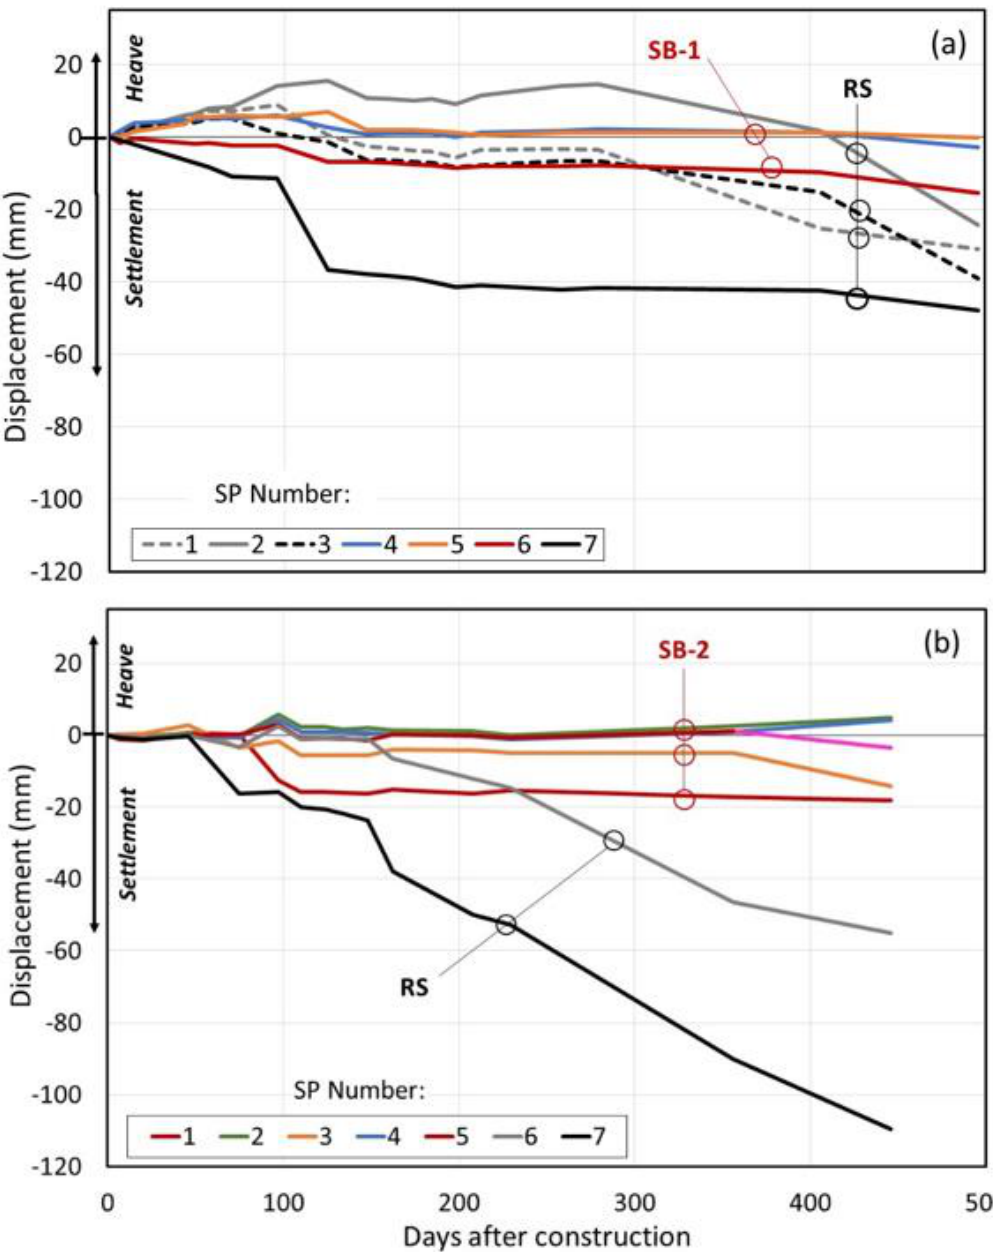
Figure 6. Cumulative soil movement in ( a ) Area 1 and ( b ) Area 2, as presented in Figure 2. The values of the cumulative soil movement of SB and RS in Areas 1 and 2 measured at 0.2 m depth were averaged as shown in Figure 7 for the purpose of fair comparison with the spatial resolution of the satellite image